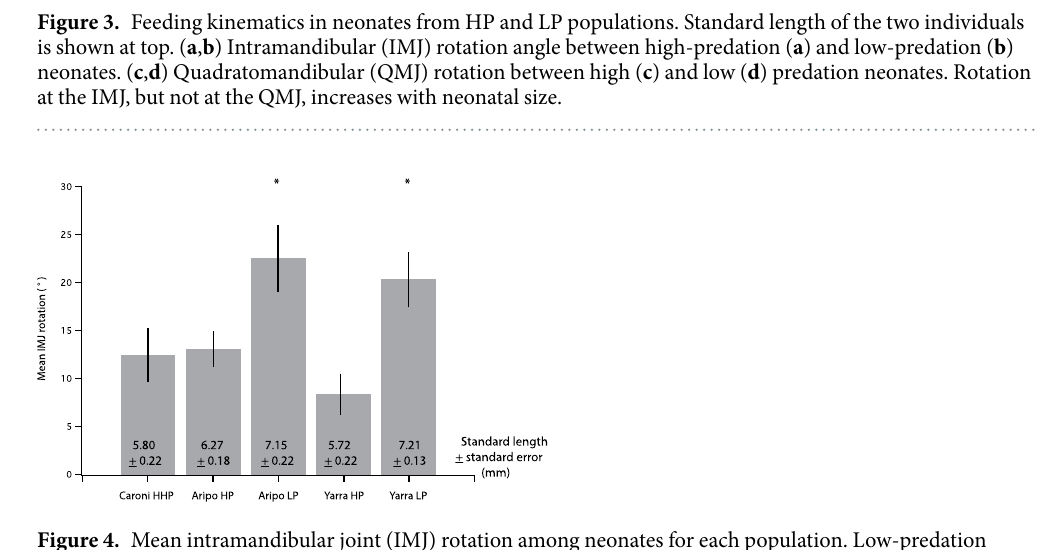
Figure 4. Mean intramandibular joint (IMJ) rotation among neonates for each population. Low-predation offspring exhibit nearly twice the IMJ mobility during feeding on encrusting food sources compared to their high-predation counterparts (asterisk indicates significance: p = 0.0007; error bars indicate standard error). Mean neonatal standard length ( ± standard error) indicated for each population. HHP, high-high-predation; HP, high-predation; LP,